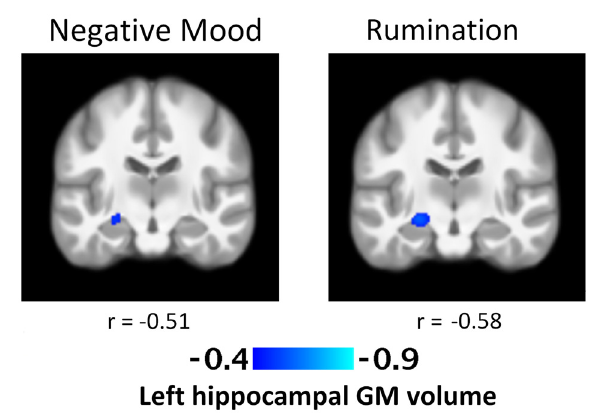
FIGURE 1 | T-Statistic maps of the negative association between regional left hippocampal gray matter volume and daily negative mood and rumination. Both images were taken at peak Montreal Neurological Institute coordinates: –24, –18, –9 and presented at the whole-brain level of voxel p < 0.001. There was no significant association after FWE correction.